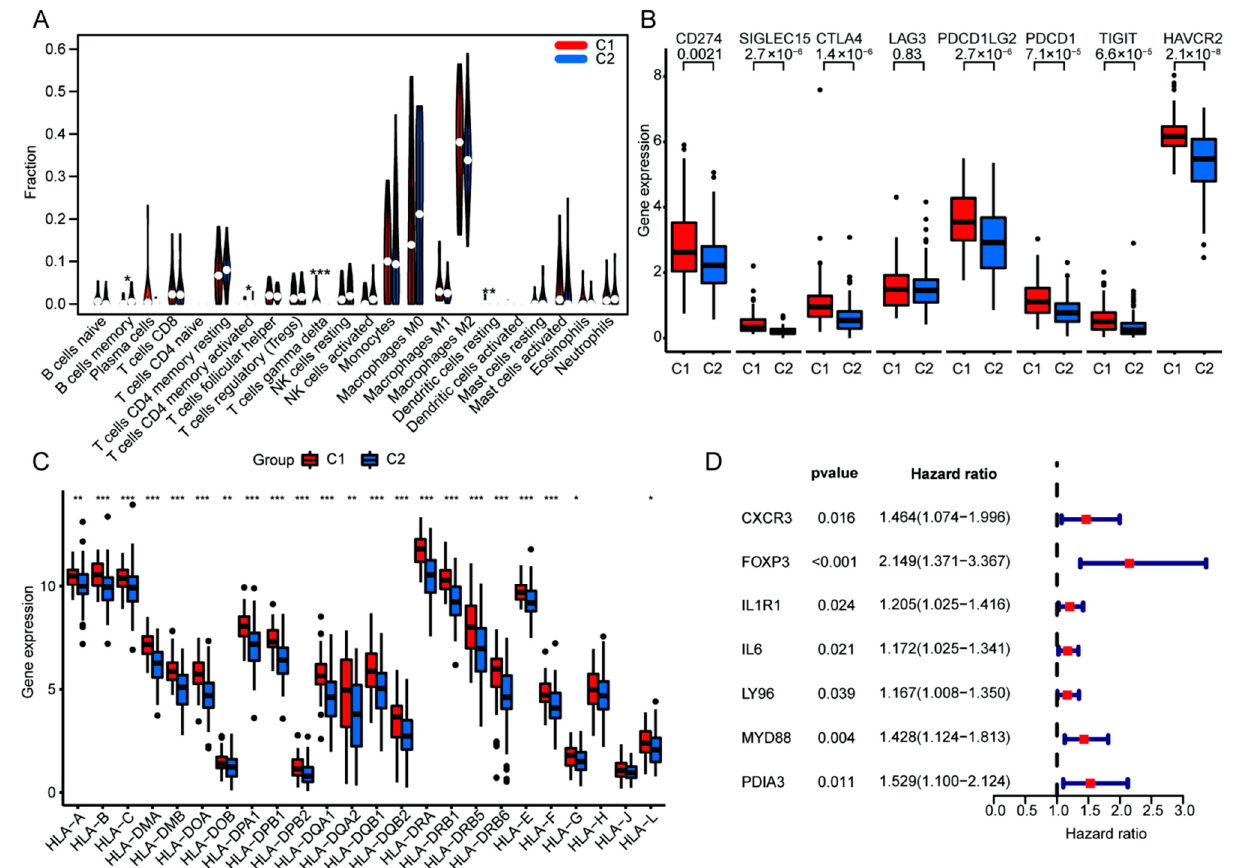
Figure 5. Comparison of TIME in ICD genotyping and revelation of the seven ICD genes with potential prognostic value. ( A ) Violin plot of immune cells in C1 and C2 group. Box plots of immune checkpoints ( B ) and HLA genes ( C ). ( D ) Univariate cox analysis for the prognostic value of the seven ICD genes according to OS. (* p < 0.05, ** p < 0.01 and *** p < 0.001 vs. indicated group, dots mean discrete value).